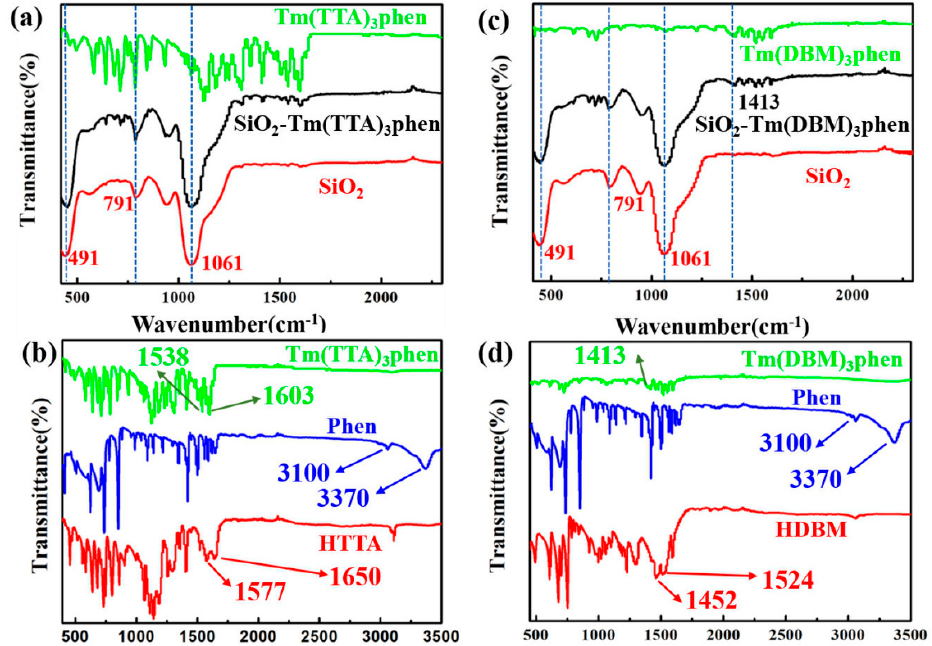
Figure 5. FT-IR spectra of ( a ) SiO 2 -Tm(TTA) 3 phen, Tm(TTA) 3 phen, and nano-SiO 2 ; ( b ) Tm(TTA) 3 phen, Phen, and 4,4,4-trifluoro-1-2-thenoyl-1,3-butanedione (HTTA); ( c ) SiO 2 -Tm(DBM) 3 phen, Tm(DBM) 3 dibenzoylmethane (HDBM).